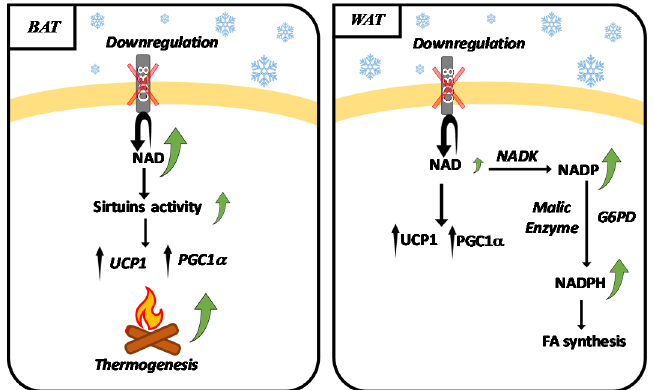
Figure 1. Cold exposure induces the downregulation of CD38 expression in BAT and WAT. During thermogenesis, CD38 expression is downregulated, both in BAT and WAT and this is paralleled by an increase in NAD + levels in BAT, supporting sirtuins’ activity. In WAT, NAD + is converted to NADP + and NADPH as a consequence of increased expression of NAD + kinase (NADK), G6PD (Glucose-6-phosphate dehydrogenase), and malic enzyme. NADPH in WAT sustains FA (fatty acid) synthesis.